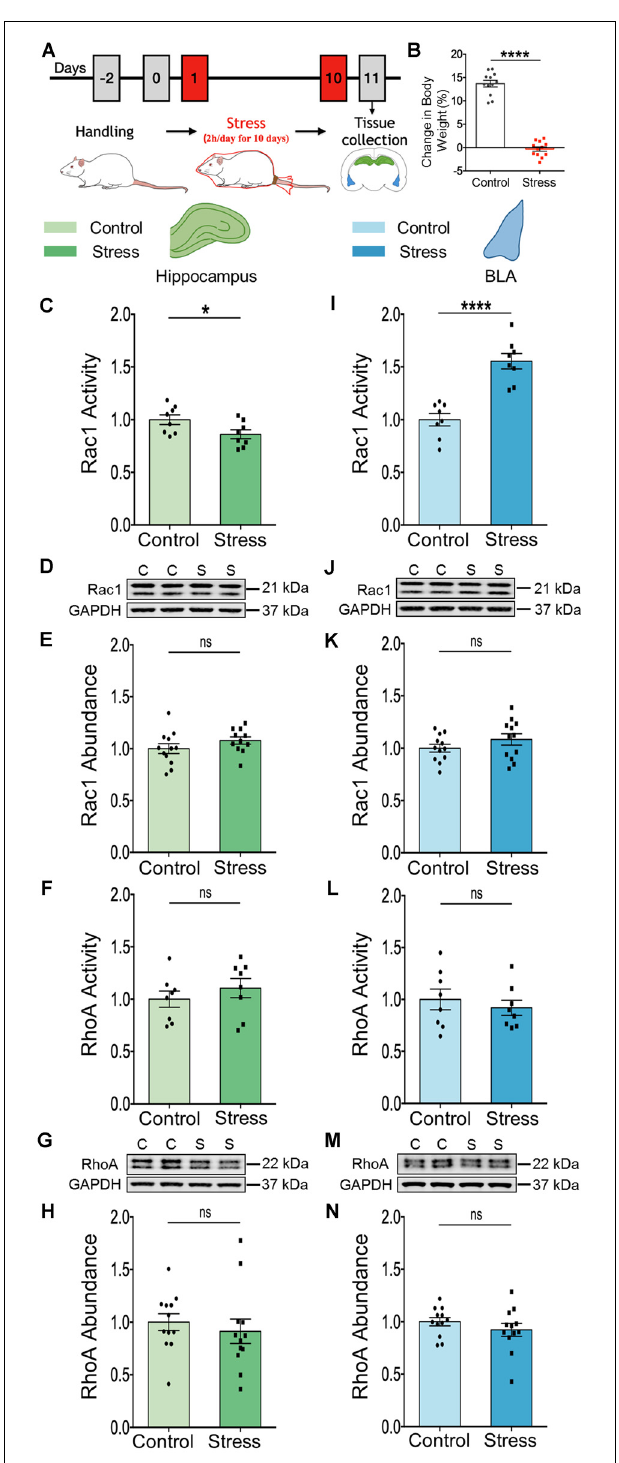
FIGURE 1 | Chronic stress elicits contrasting effects on the activation profile of Rac1-GTPase in the hippocampus and amygdala. (A) Schematic representation of experimental protocol. Male rats were subjected to chronic immobilization stress for 2 h/day for 10 days. Animals were then sacrificed for tissue collection. (B) Rats subjected to chronic stress show a significant